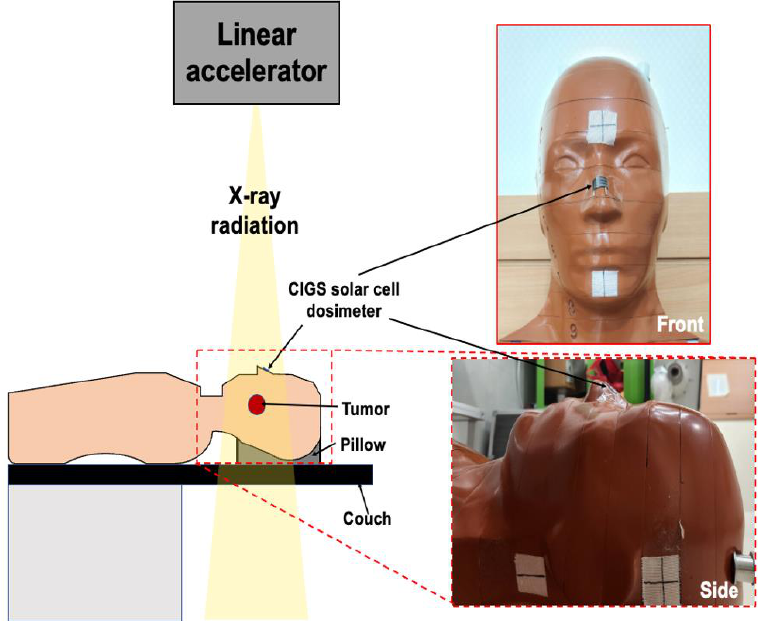
Figure 9. A simple example of in vivo dosimetry using our system based on copper indium gallium selenide (CIGS) solar cell. The CIGS solar cell was attached to the surface of the anthropomorphic phantom in the bent condition in this example.